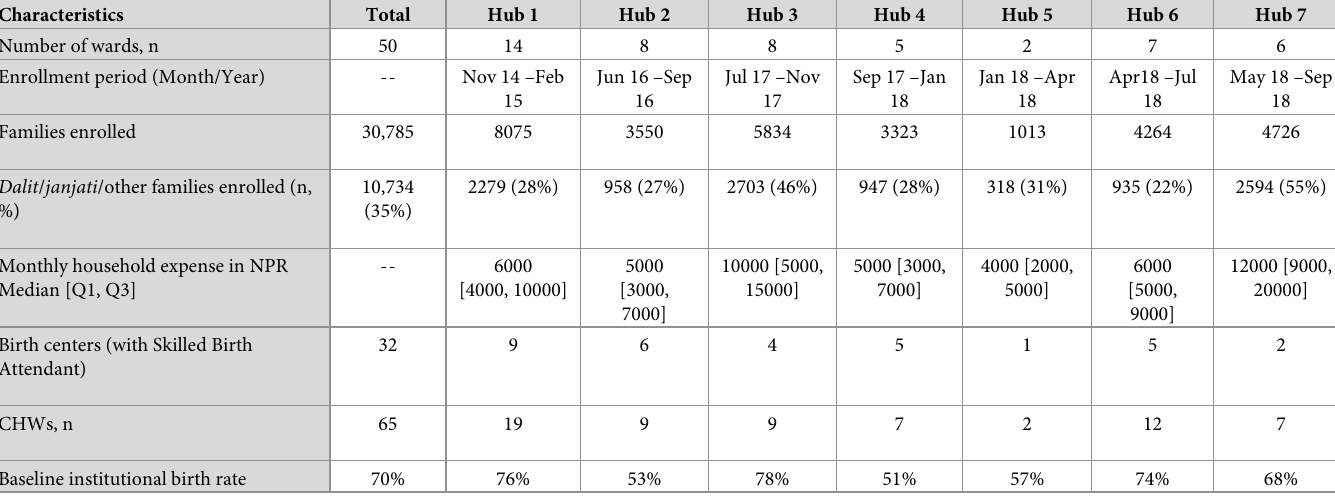
Table 1. Socio-demographics of study catchment